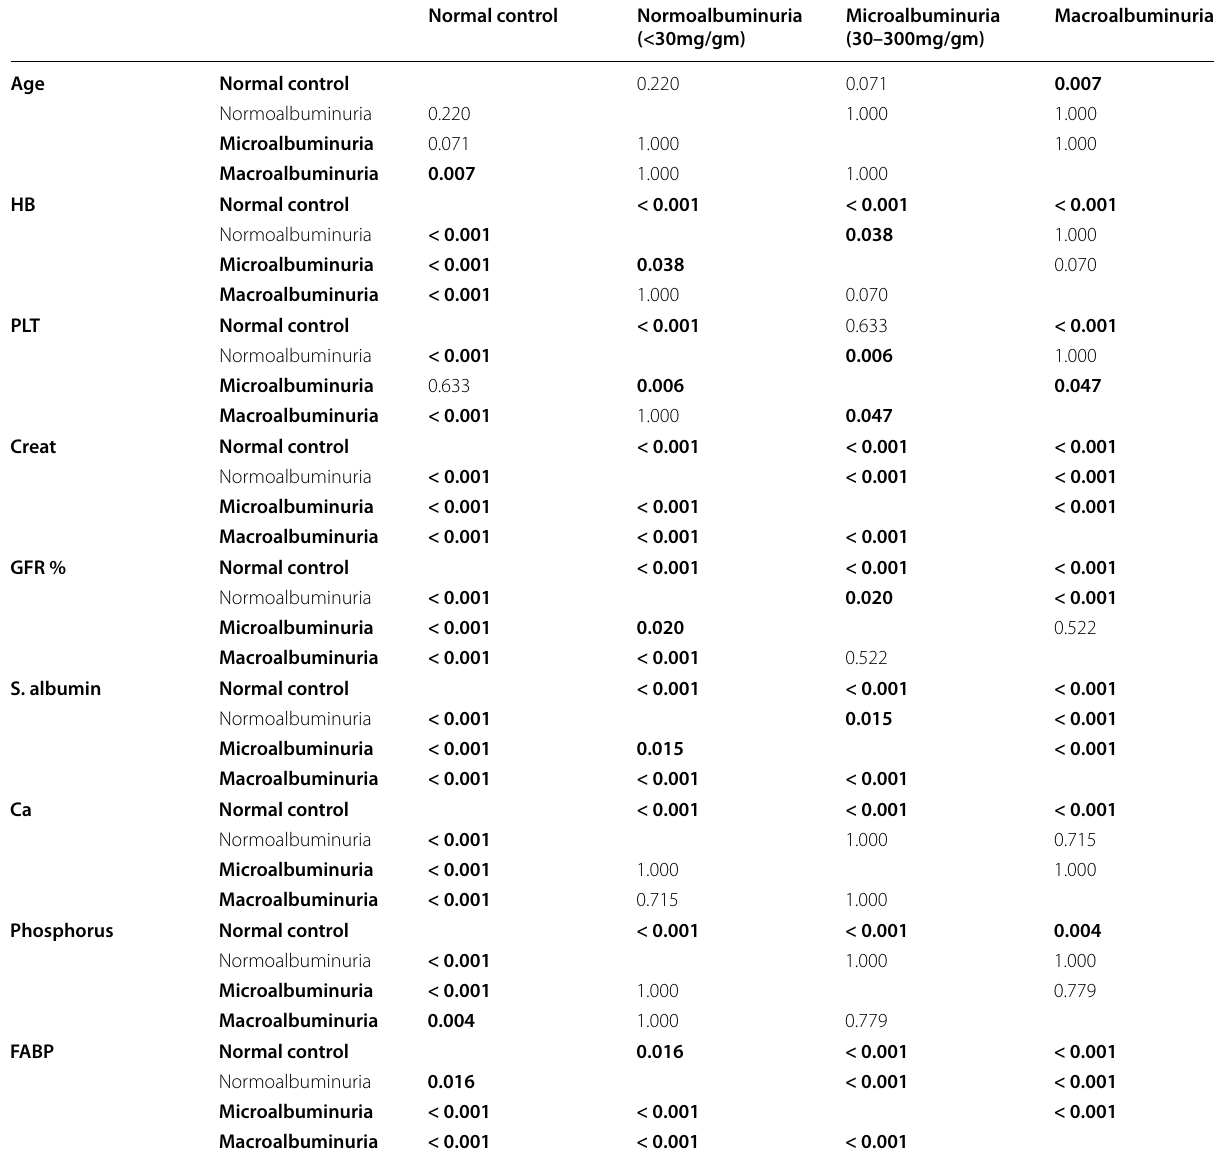
Table 6 Comparison between studied groups and control according to all parameters Normal